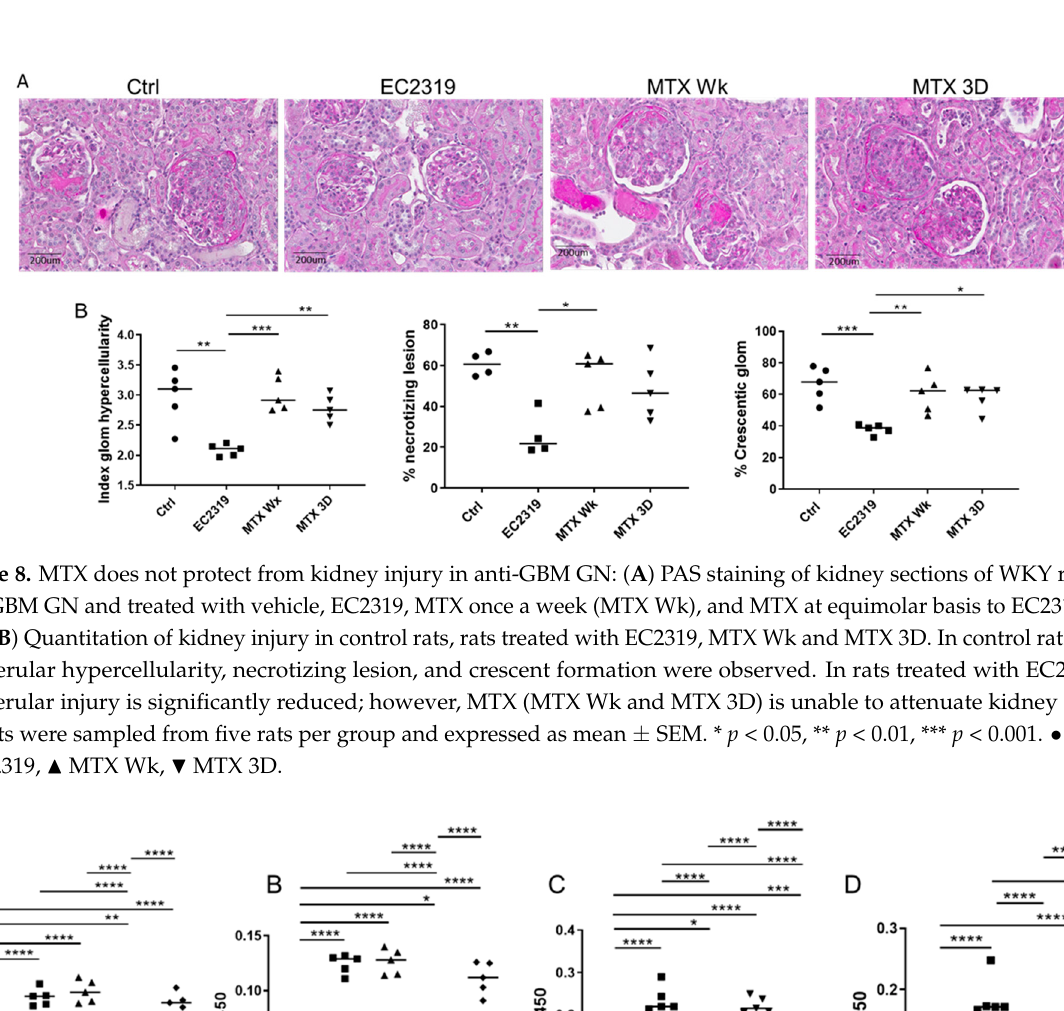
Figure 10. Glomerular rabbit IgG deposition is not affected by treatment with EC2319, EC2319/FA competitor, or MTX; however, glomerular rat IgG deposition is decreased in EC2319- and MTX Wk-treated rats with GN. ( A ) Immunofluores- cence staining of rabbit IgG reveals rabbit IgG along the capillary walls of glomeruli in a linear pattern with no discernible difference in the intensity between the groups. ( B ) Quantification intensity of rabbit IgG immunofluorescence staining. ( C ) Immunofluorescence staining of rat IgG shows a decrease in the intensity within the glomeruli in rats treated with